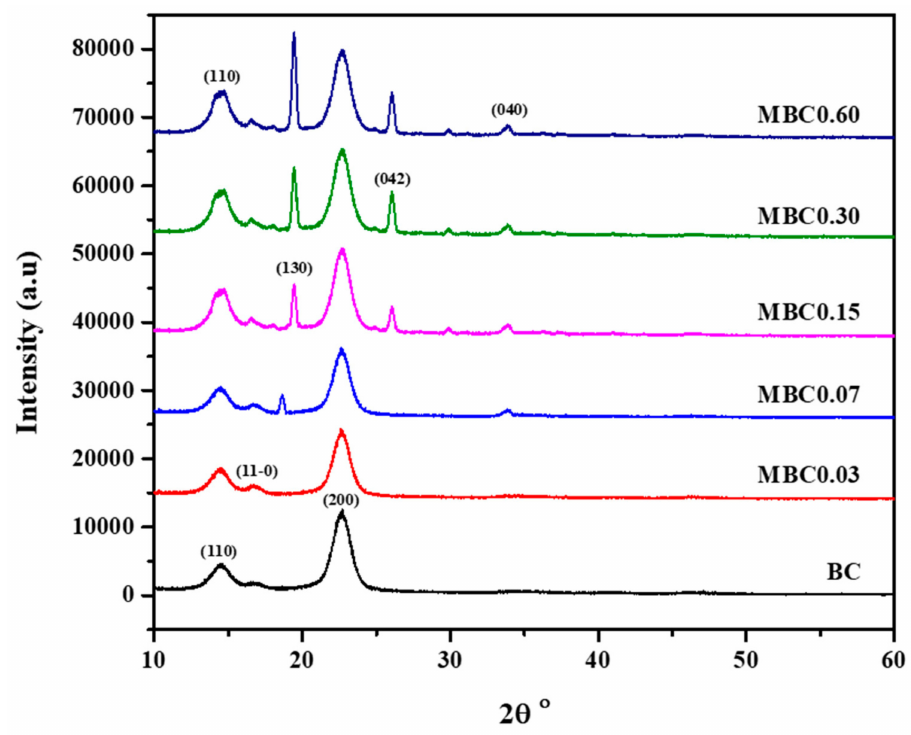
Figure 4. X-ray diffraction (XRD) spectra of the unmodified and modified